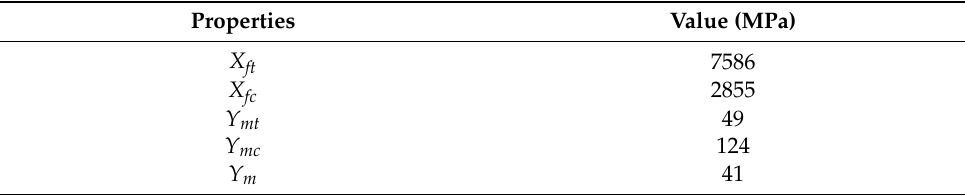
Table 5. Strengths of the composite constituents.